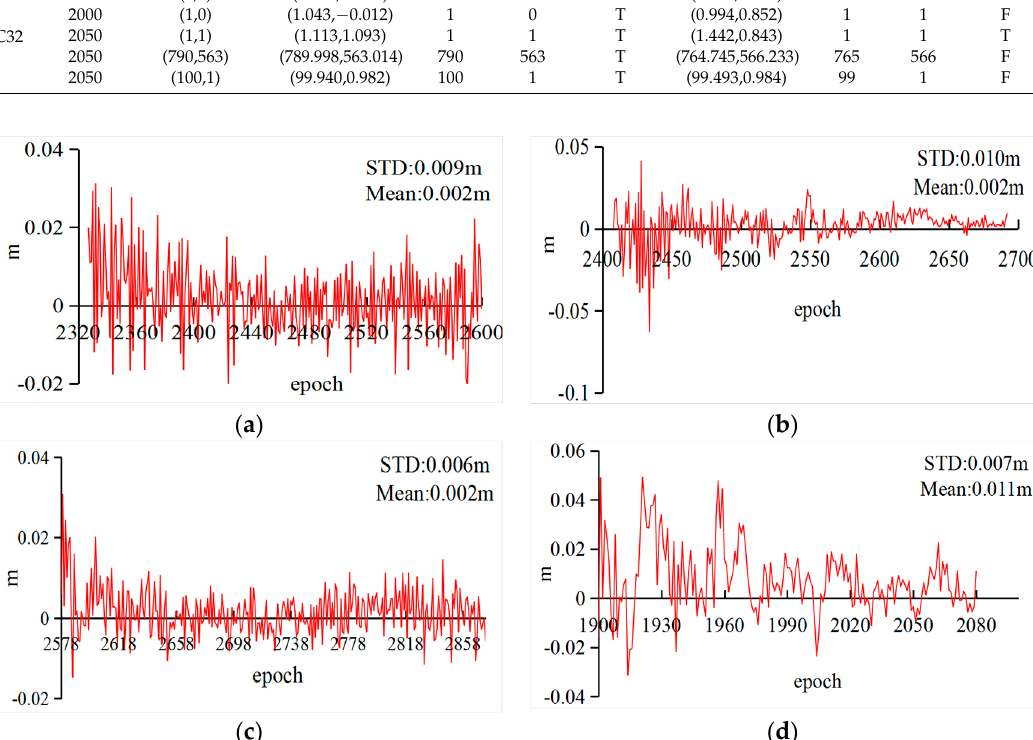
Figure 4. The differences between the estimated and predicted ionospheric delays (( a ) G01; ( b ) C06; ( c ) C14; and ( d ) C32).